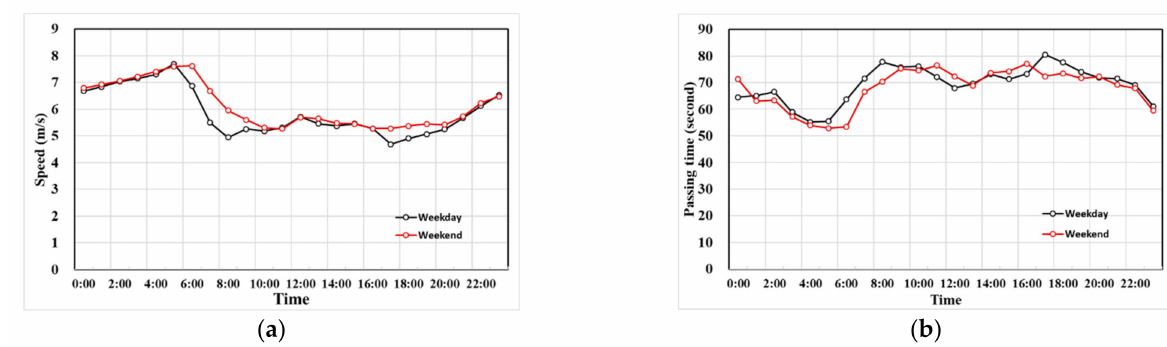
Figure 11. The average speed and the passing time on weekdays and weekends; ( a ) The speed ( b ) The passing